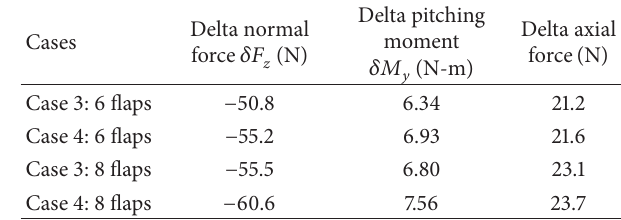
Table 4: Comparison of delta forces and moments, case 3 versus case 4 , 𝑀 = 2.5, 𝛼 = 0 ∘